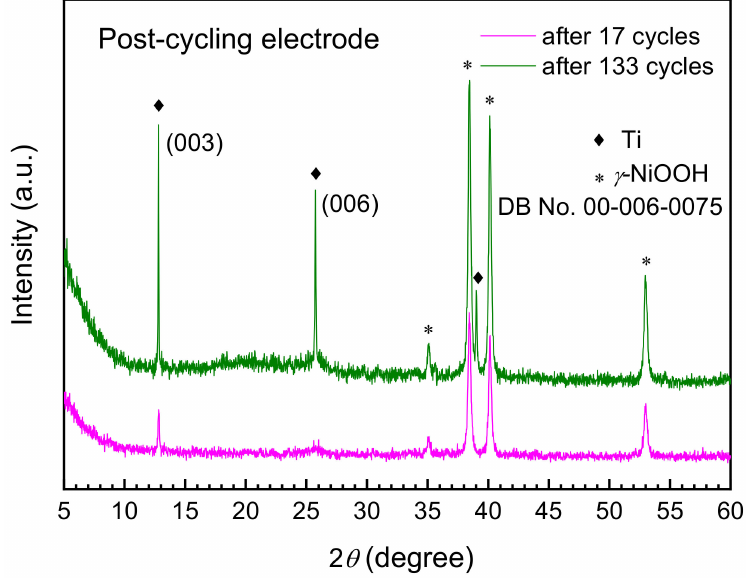
Figure 6. The powder XRD of post-cycling Ni(dto)-DH/C electrodes using Ti foil coated by Ni(dto). γ -NiOOH mainly exposed three facets including (003), (006), and (101). The interplanar spacing for the (003) and (006) facets was 6.97 Å and 3.47 Å, respectively [62]. The